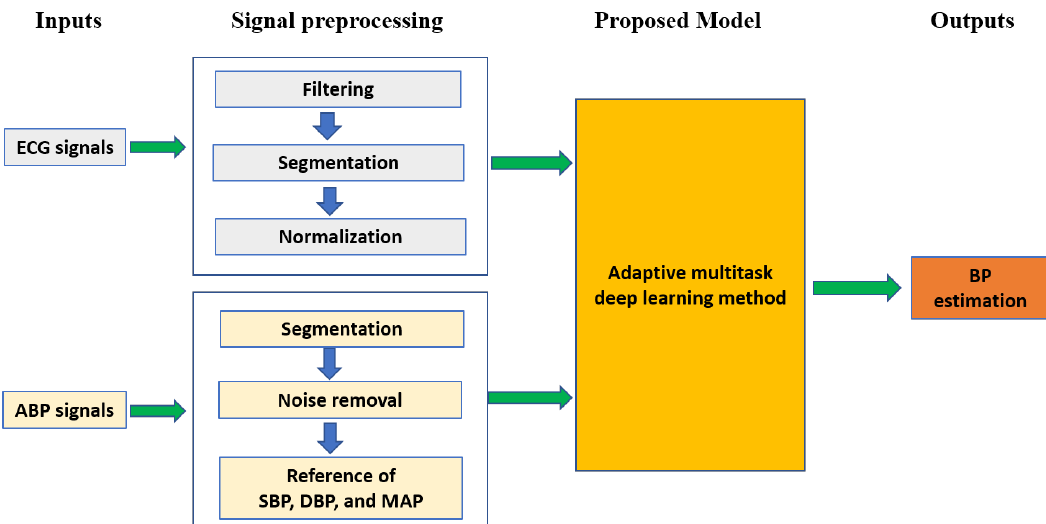
Figure 1. Pipeline of blood pressure estimation-based electrocardiograph (ECG) signals. The proposed multitask network is iteratively updated in the training phase by computing the root mean square loss values between estimated BP values and ground truth BP values. ABP means arterial blood